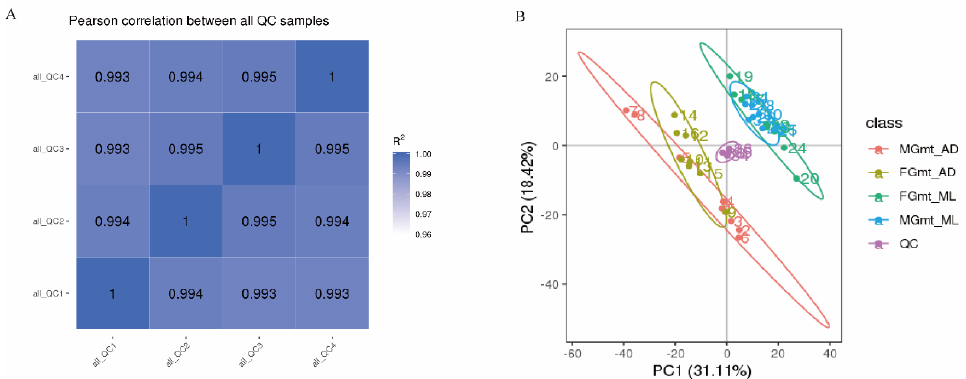
Figure 1. Correlation analysis and PCA. The correlation analysis is shown in ( A ), the distance heat map, showing the Pearson correlation coefficient values between samples. The principal component analysis based on eight replications of MG_AD, FG_AD, FG_ML, and MG_ML is shown in ( B